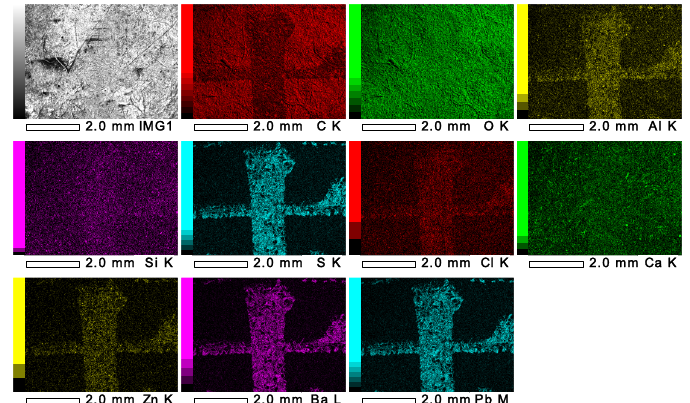
Figure 6. SEM-EDS mapping image of area 2-a.